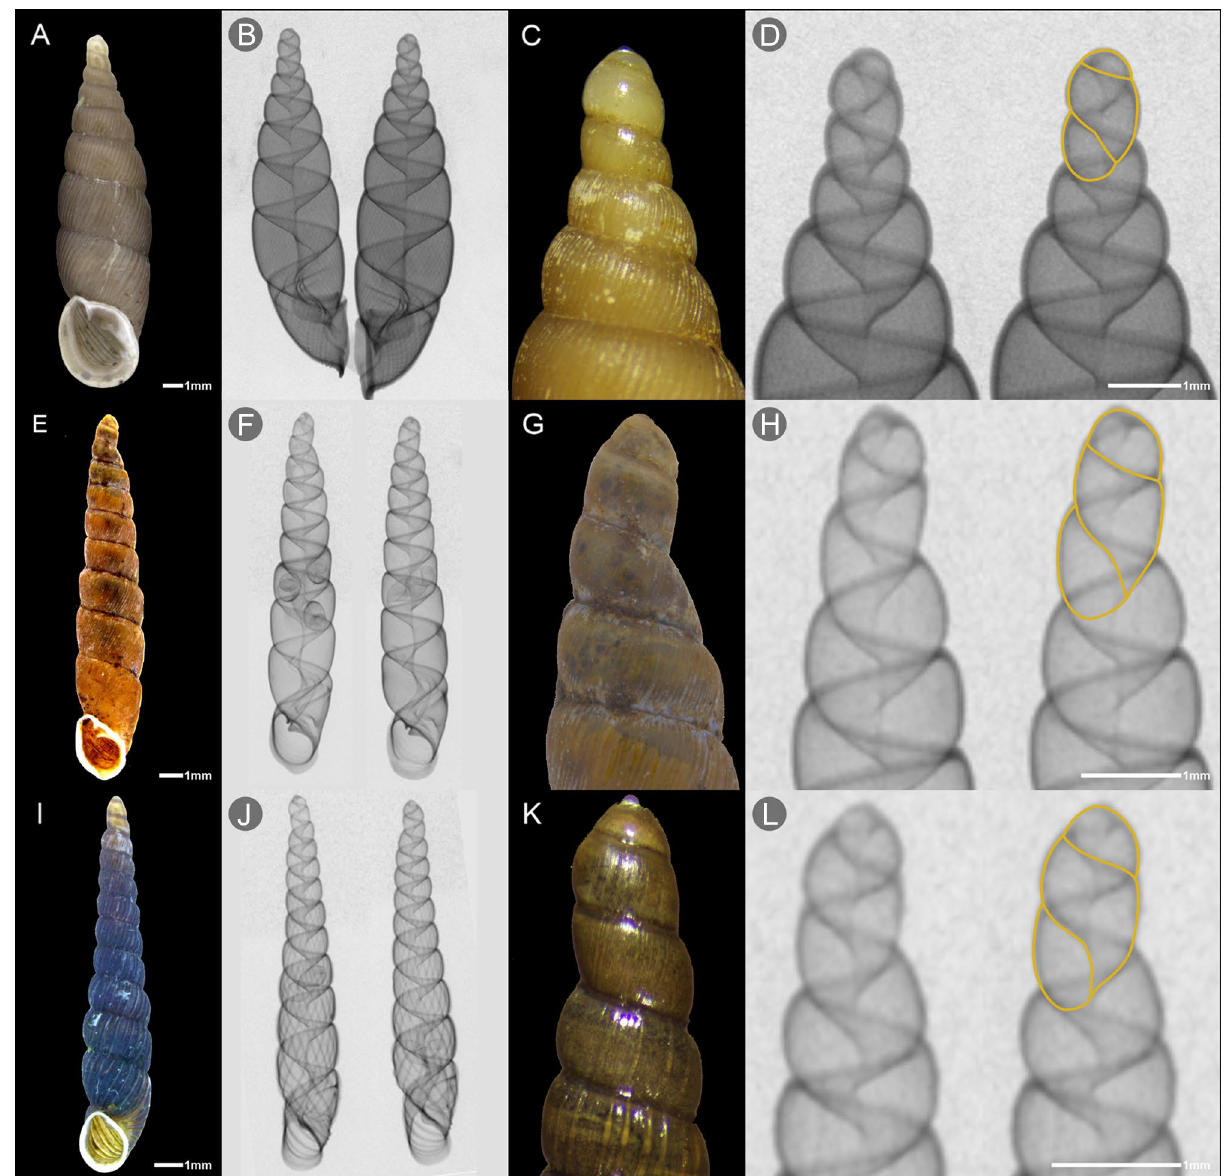
Figure 2. Width difference between protoconch and teleoconch in Stereophaedusa addisoni ( A–D , upper row), Euphaedusa cylindrella ( E–H , middle row), Euphaedusa steetzneri ( I–L , lower row). ( A,C,E,G,I,K ) Adult shells with very narrow apical whorls; ( B,F,J ) X-rayed adults; ( F,J ) with retained embryos inside; ( D,H,L ) X-rays of apical part of adult shell with schematic drawings of a